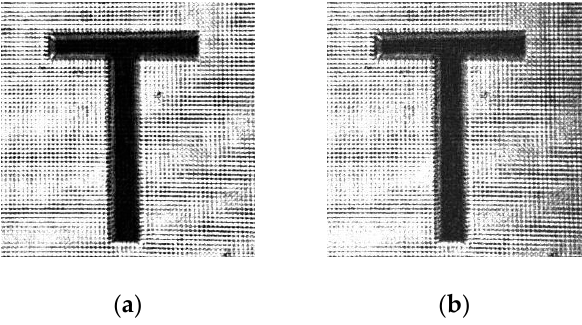
Figure 8. Image reconstruction results in polarization holography: ( a ) original transmitted image; ( b ) reconstructed image.